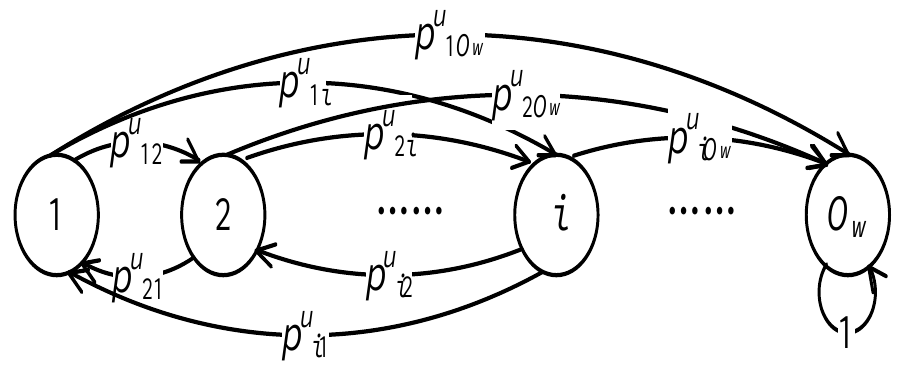
Figure 3. The Markov model of node mobility. Each state in the model represents the zone at which a node resides and the transition probability indicates the probability that node transfers among